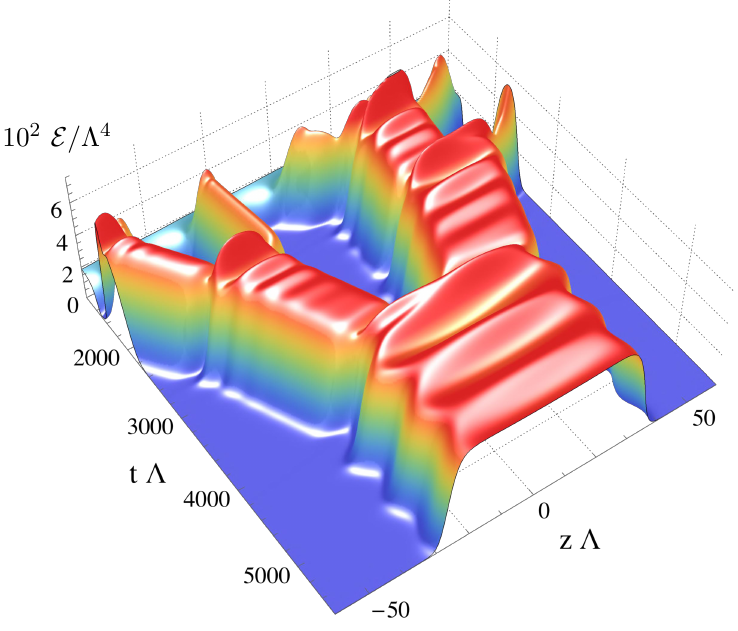
Figure 2 . Evolution of the energy density as a function of time and space for an initial homoge- neous state in the spinodal region that is slightly perturbed at t = 0 . Figure taken from